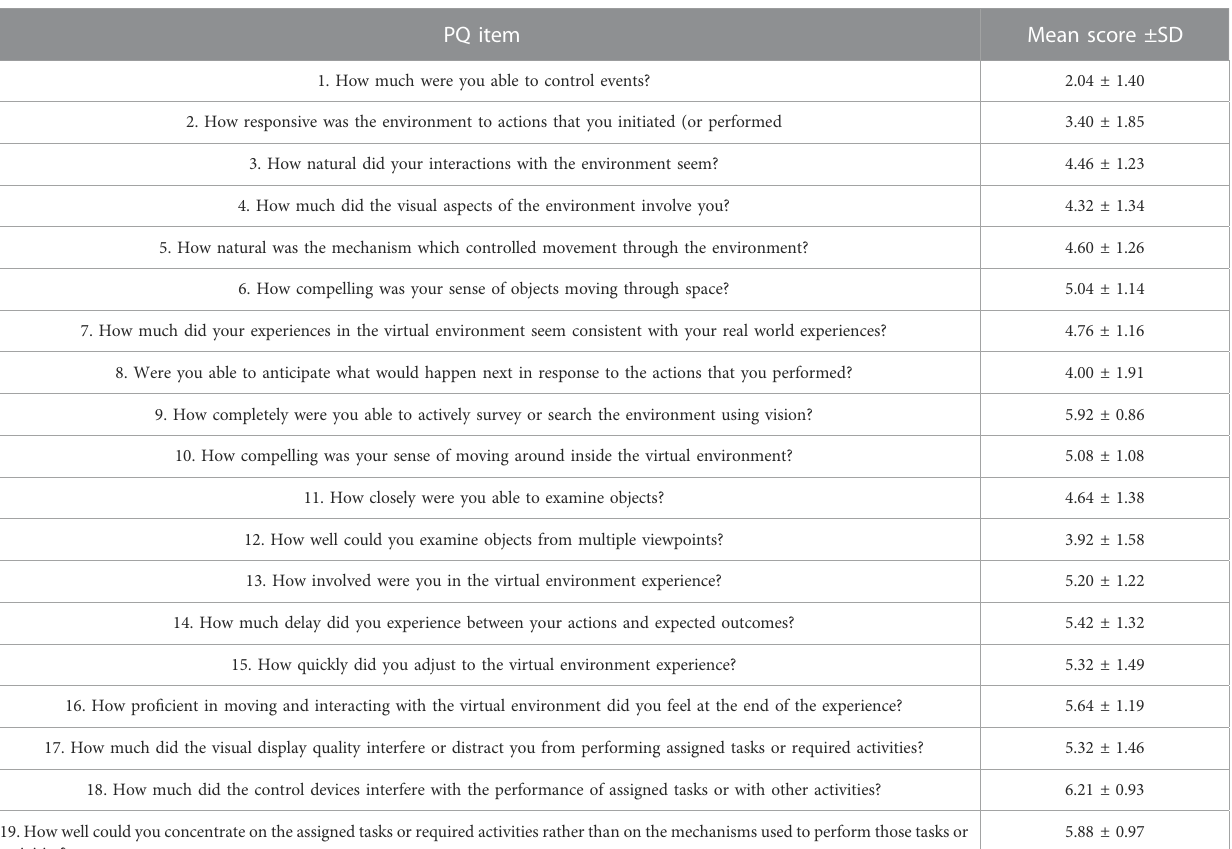
TABLE 3 Presence Questionnaire individual items analysis. Items were rated from 1 to 7, with higher scores representing increased immersion; items 14, 17, and 18 are